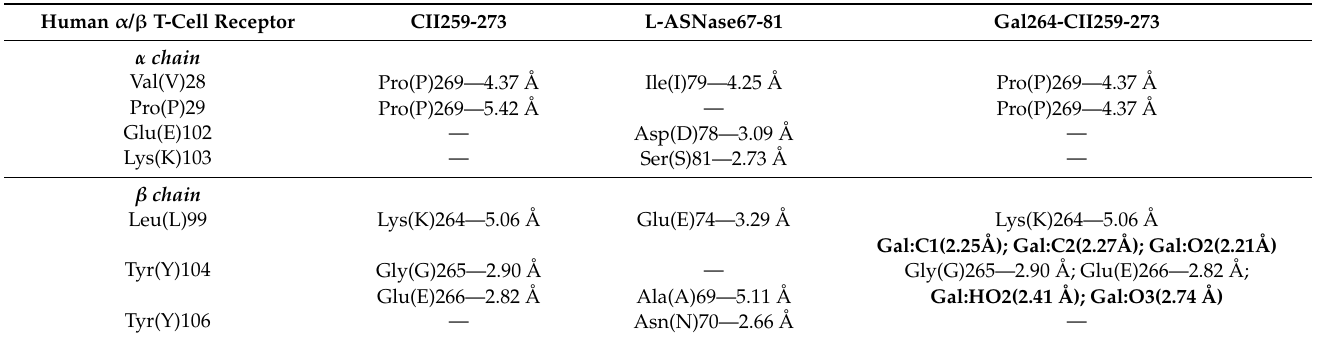
Table 3. Important hydrogen bonds between a human α / β T-cell receptor and the peptides CII259- 273, L-ASNase67-81, and Gal264-CII259-273.